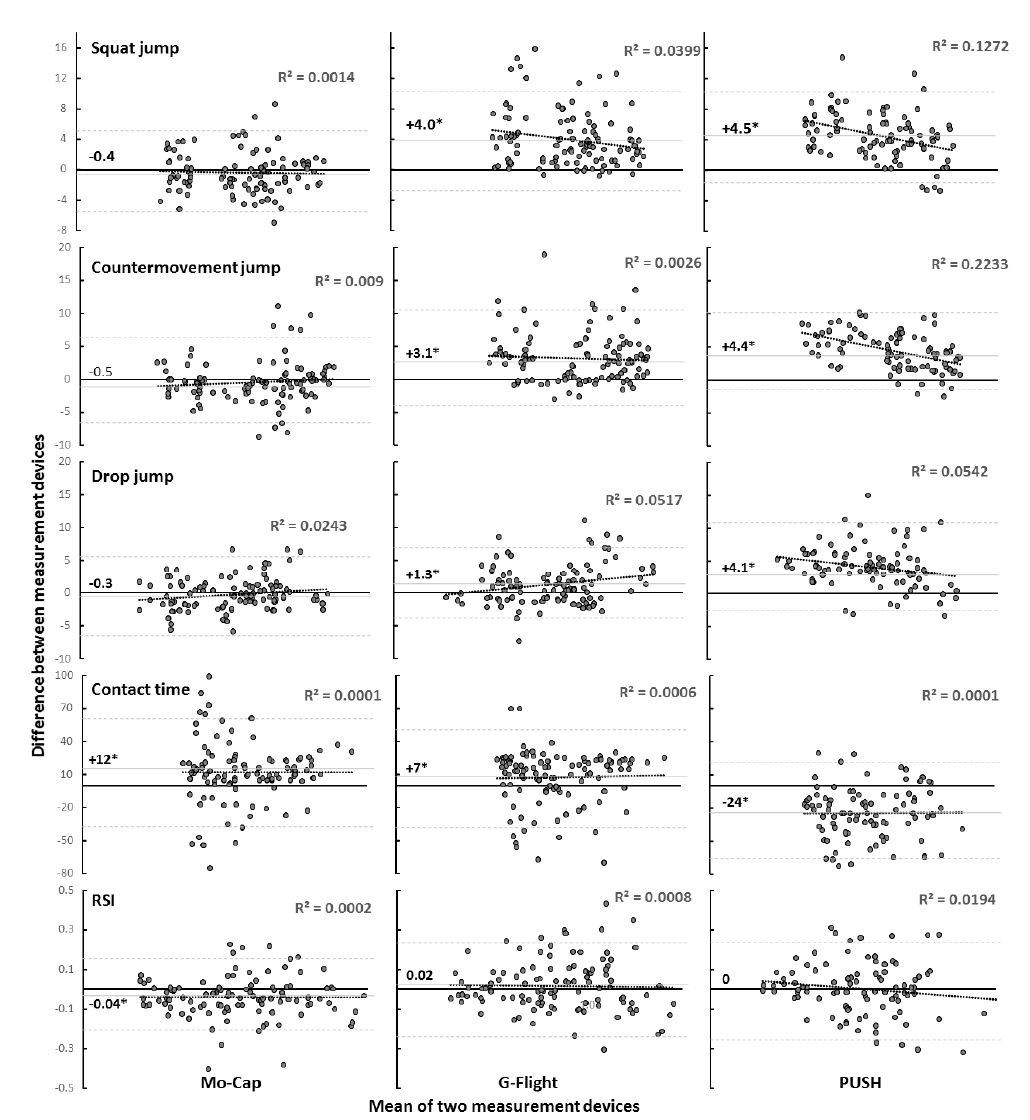
Figure 4. The di ff erence in the mean jump performance measures between force-plate and Mo-cap, Figure 4. The difference in the mean jump performance measures between force-plate and Mo-cap, G-Flight, and G-Flight, and PUSH.